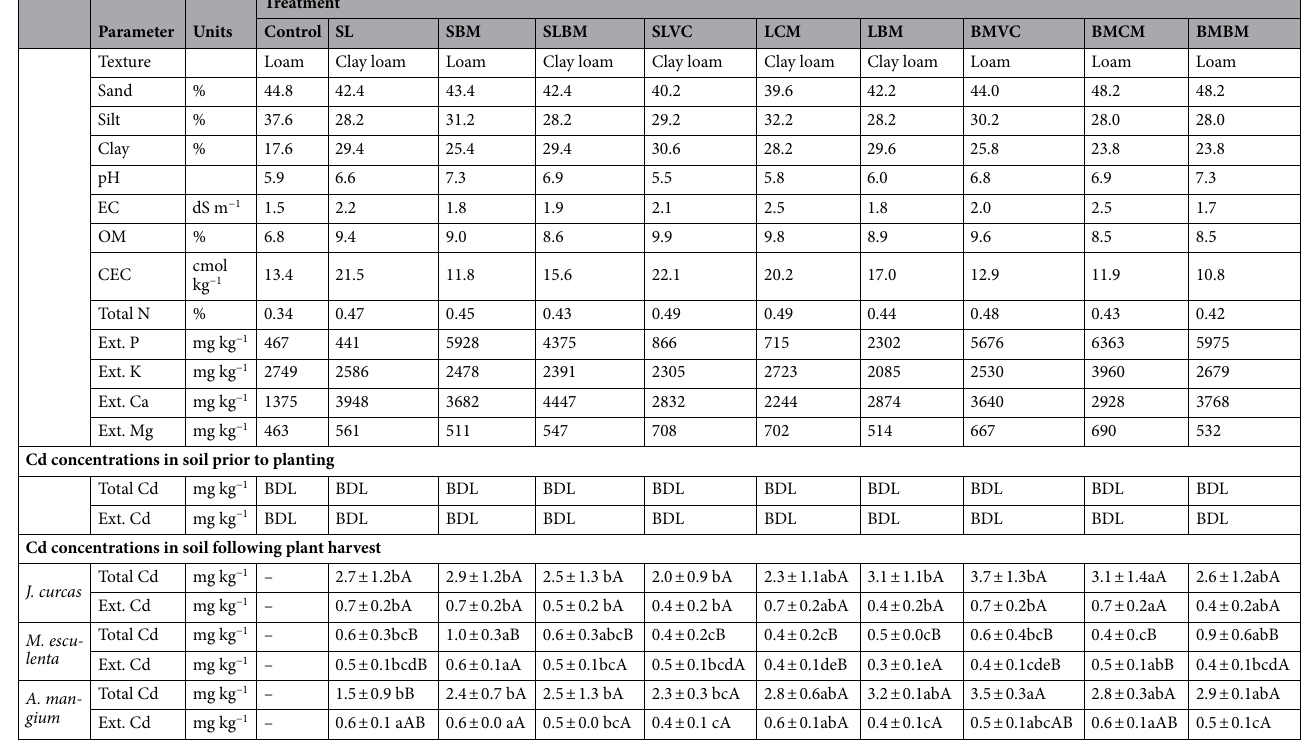
Table 1. Physicochemical properties of the amended soils. BDL below detection limits , CEC cation exchange capacity , EC electrical conductivity , Ext. extractable , OM organic matter , Control commercial soil ,